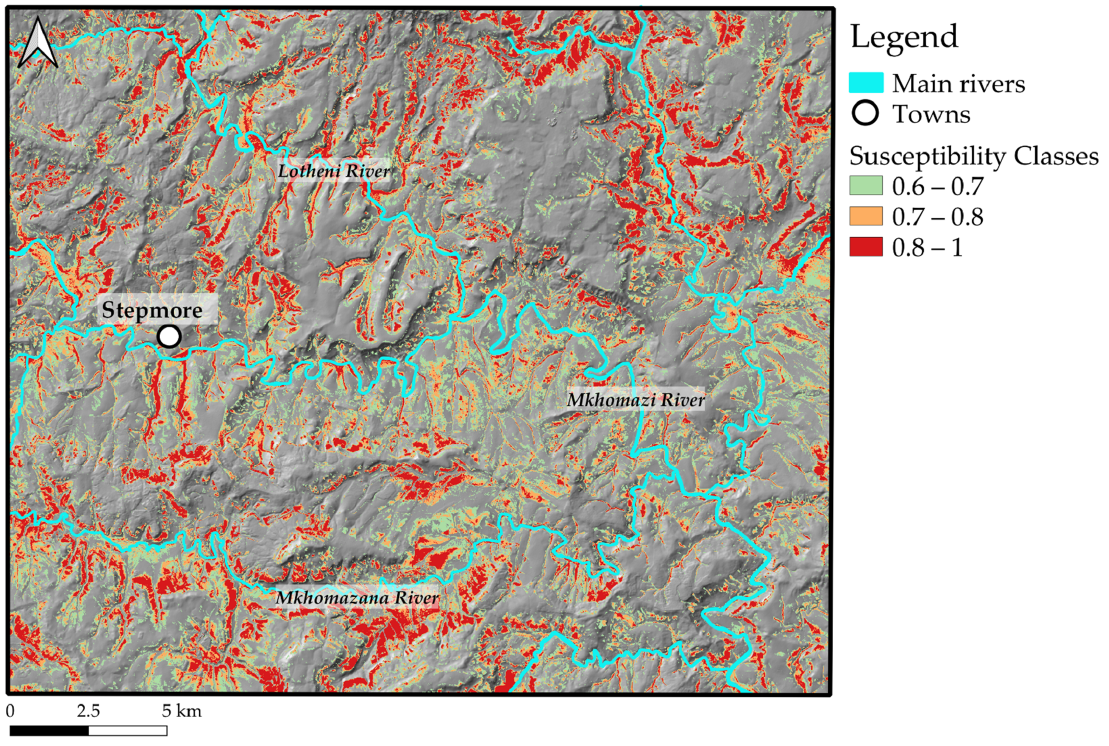
Figure 11. Integration of the two susceptibility maps that potentially represent the spatial distribution of colluvial deposits.